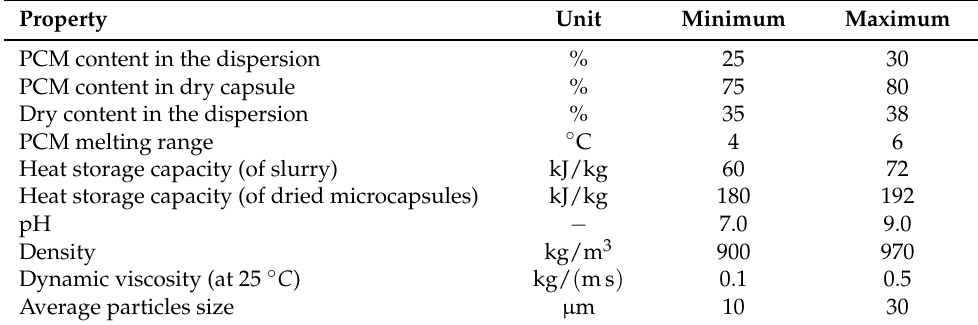
Table 1. The thermophysical properties of the Phase Change Material (PCM) used during the experiments